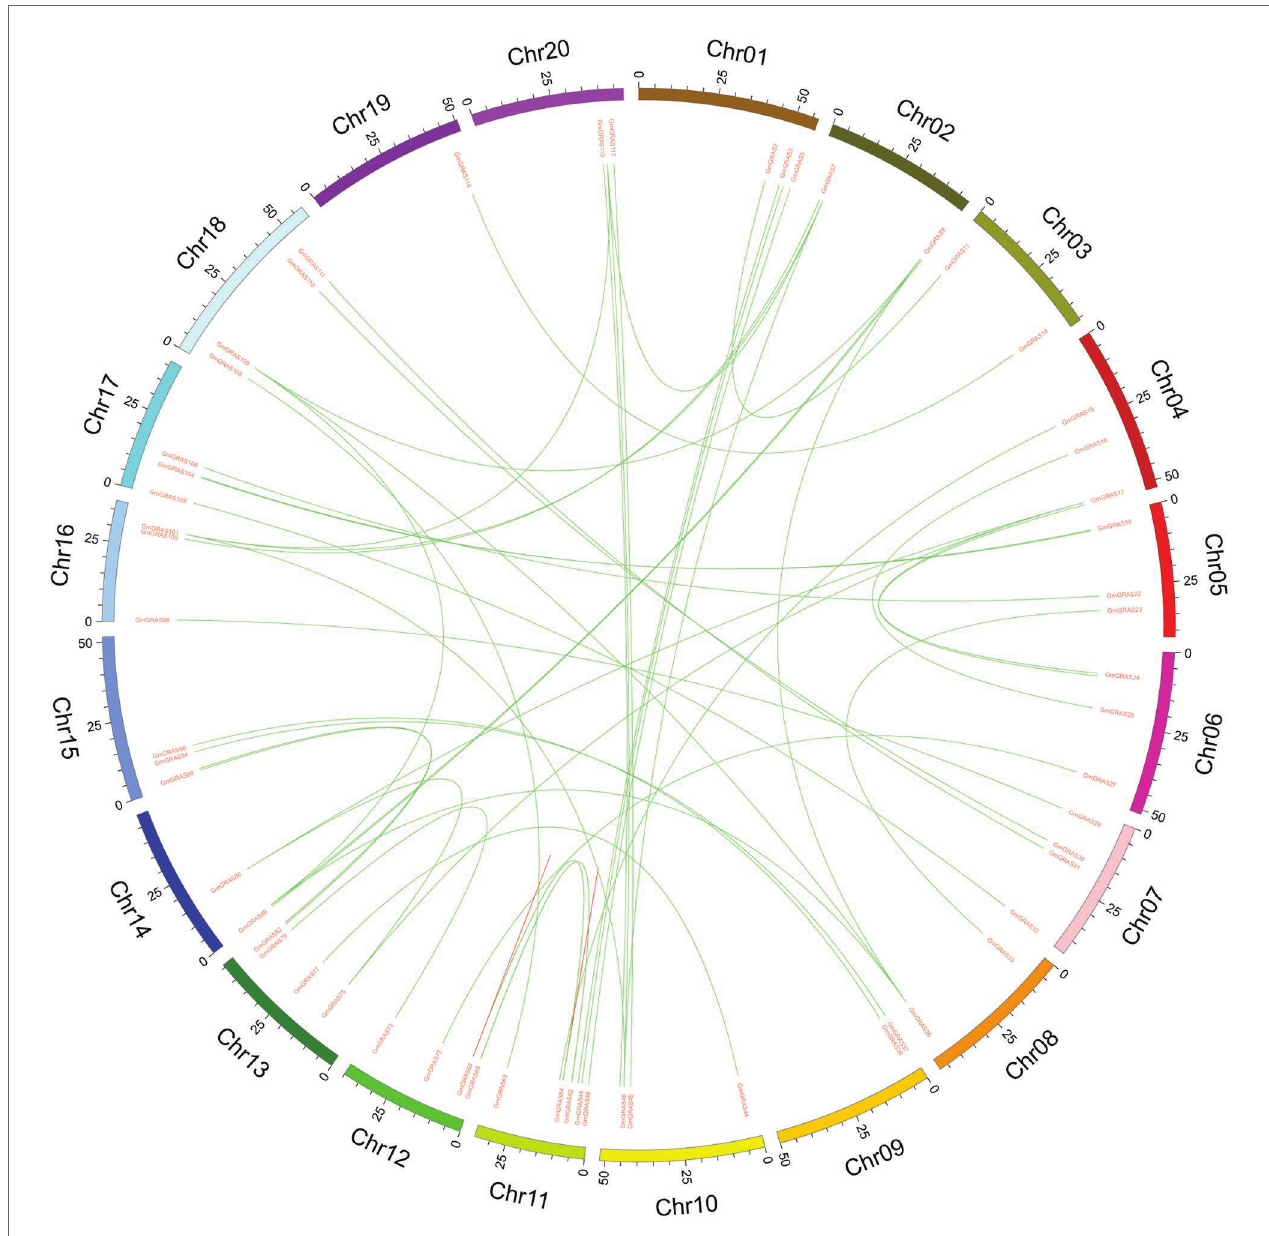
FIGURE 6 | Distribution of segmentally duplicated GmGRAS genes on soybean chromosomes. Green lines indicate duplicated GRAS gene